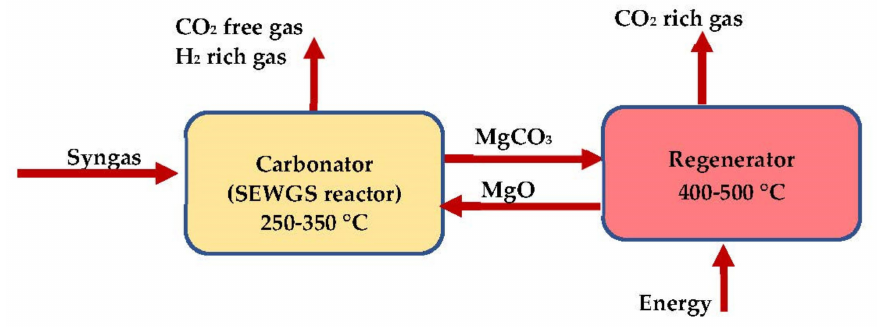
Figure 17. Carbonation–regeneration cycle of Mg-based